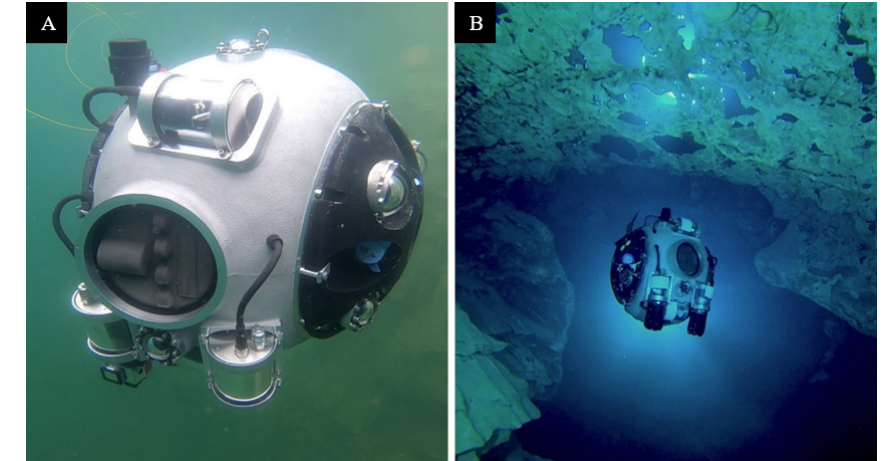
Figure 1. UX-1 robot (figures from UNEXMIN GeoRobotics Ltd., 2020).